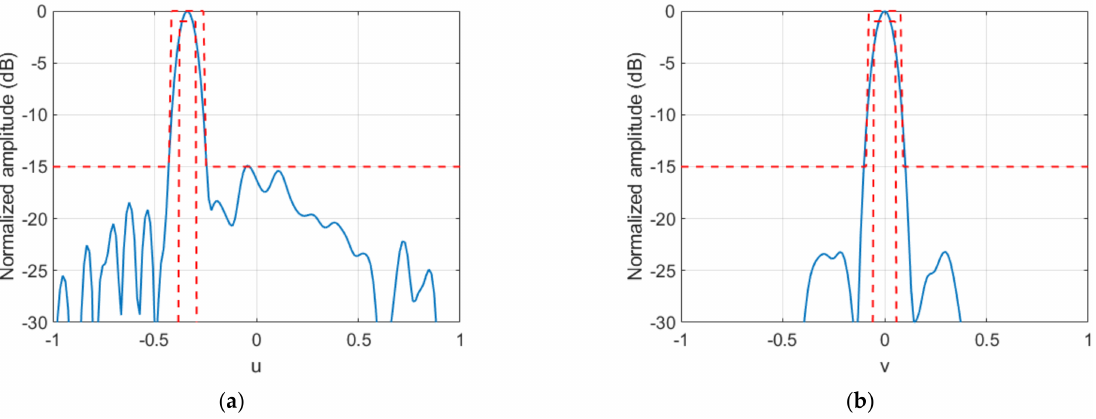
Figure 5. Case 1, Stage#1: main cuts of the synthesized radiation pattern and comparison with templates. ( a ) cut v = 0; ( b ) cut u = −